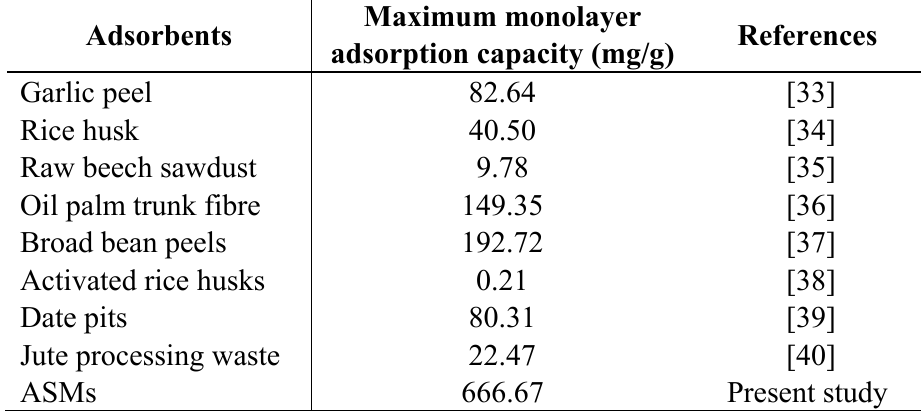
Table 3. Comparison of the maximum monolayer adsorption of MB onto various